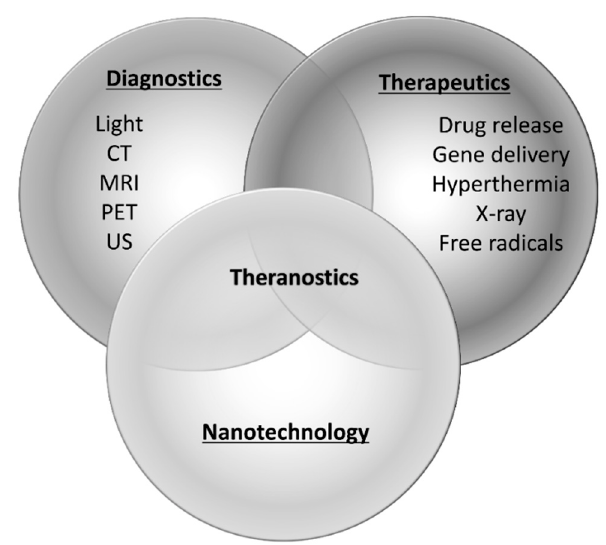
Figure 1. Paradigm of theranostics. CT; computed tomography, MRI; magnetic resonance imaging, PET; positron emission tomography, US; ultrasound.